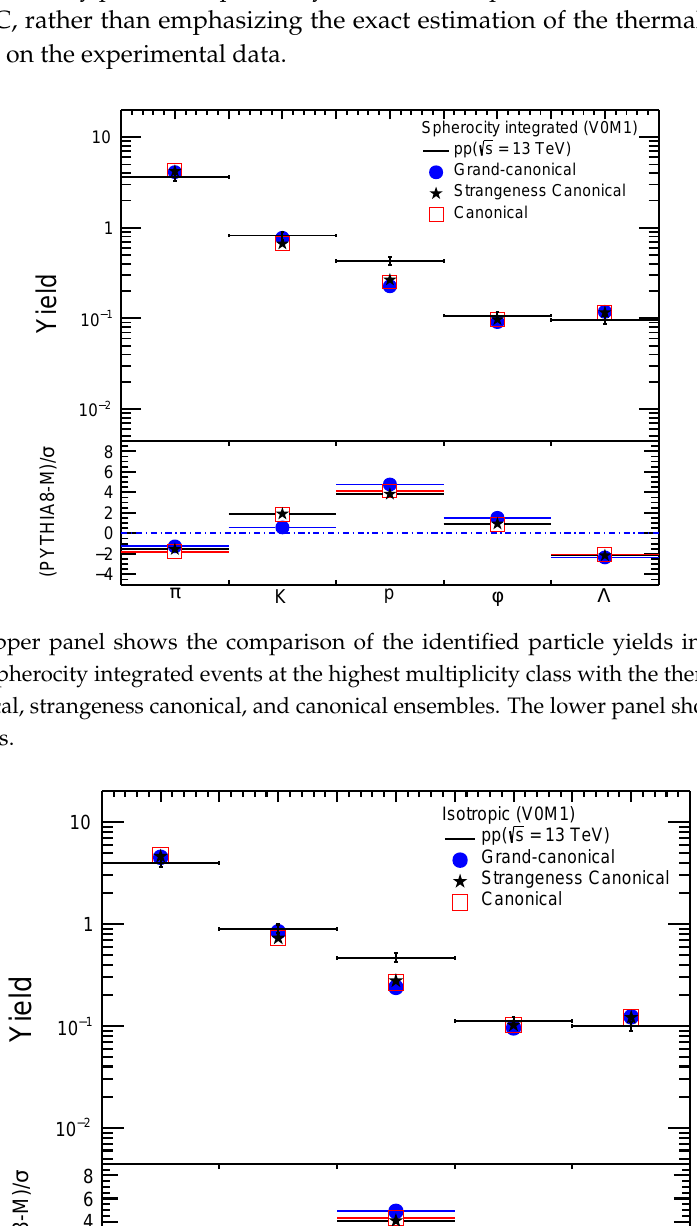
Figure 4. The upper panel shows the comparison of identified particle yields in pp collisions at for isotropic events at the highest multiplicity class with the thermal model using the grand canonical, strangeness canonical, and canonical ensembles. The lower panel shows the deviation from the